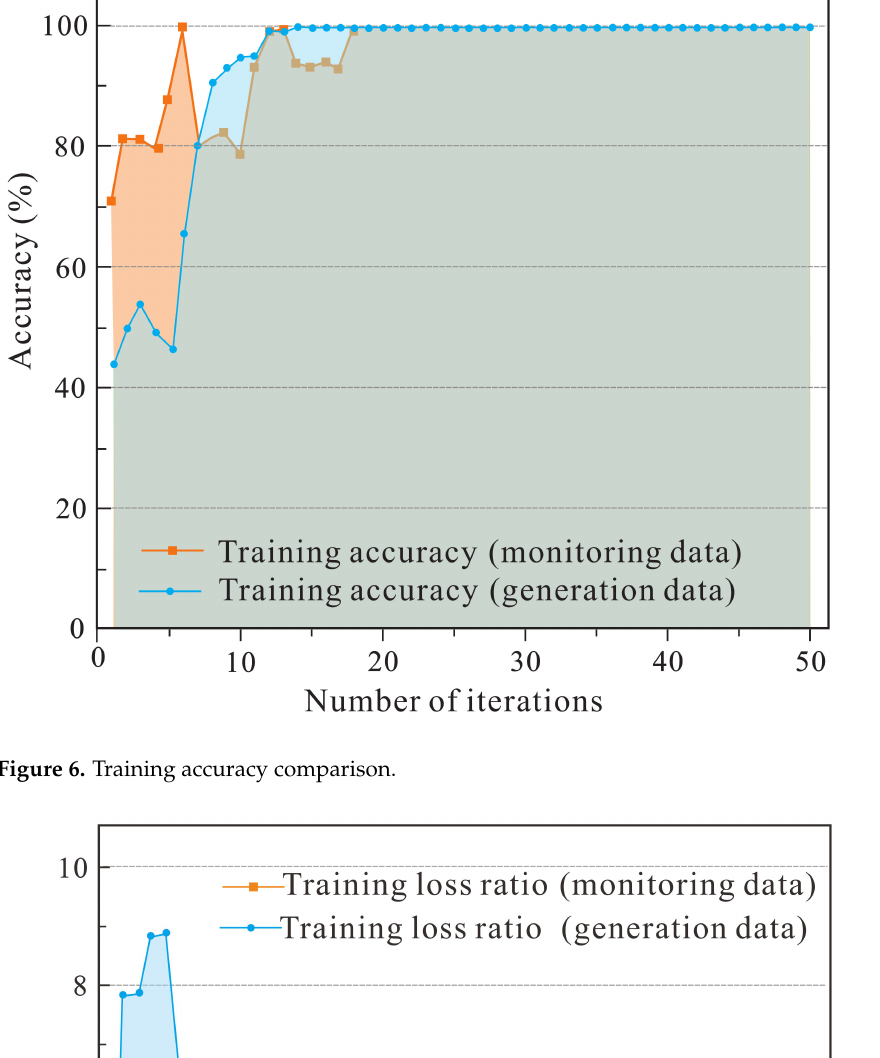
Figure 6. Training accuracy comparison.